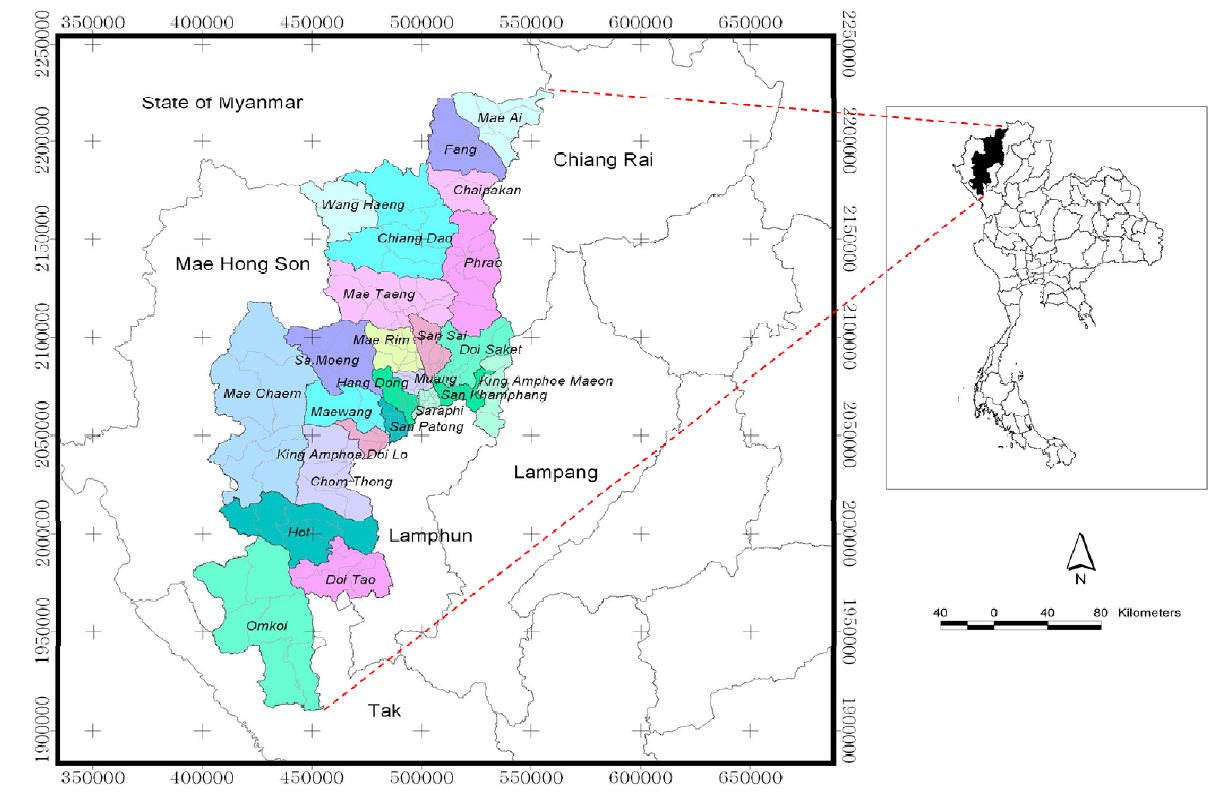
Figure 2. Study area: Chiang Mai Province,